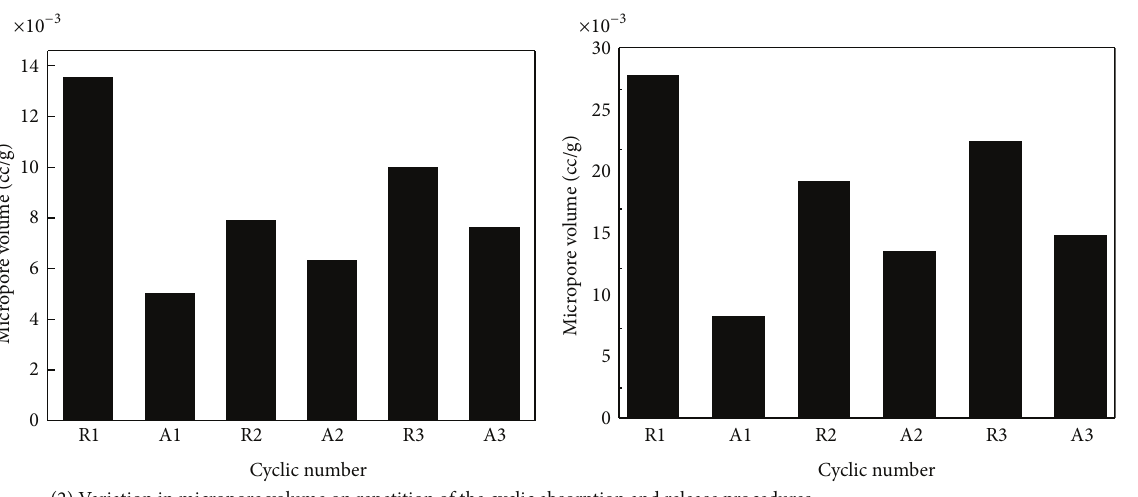
Figure 9: Variation of the specific surface area and micropore volume of calcined dolomite samples on cyclic absorption and release procedures. Dolomite samples calcined in the Ar atmosphere and in vacuum (b) (R: after CO 2 release; A: after CO 2